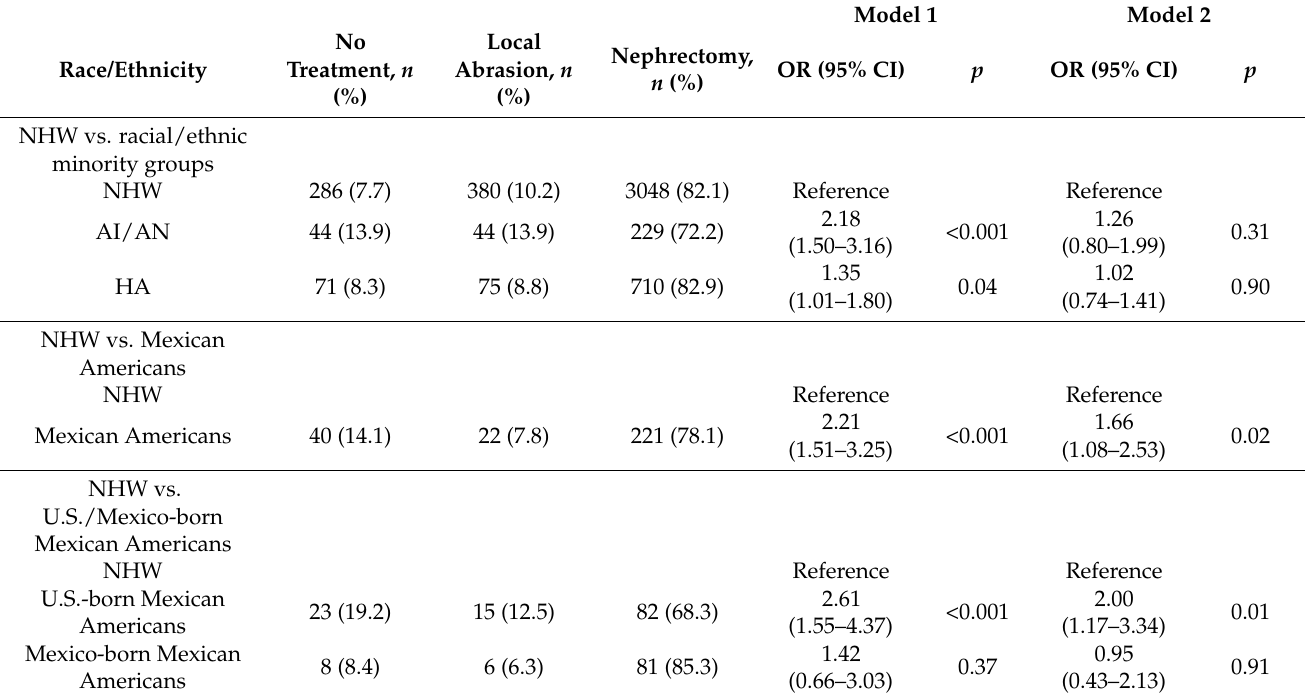
Table 3. Associations between race/ethnicity and no surgical treatment.